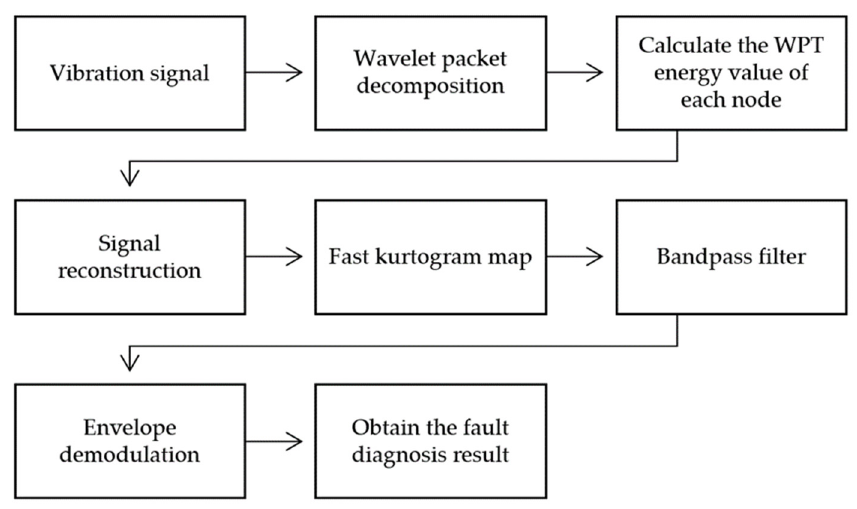
Figure 8. Rolling bearing fault diagnosis flowchart.